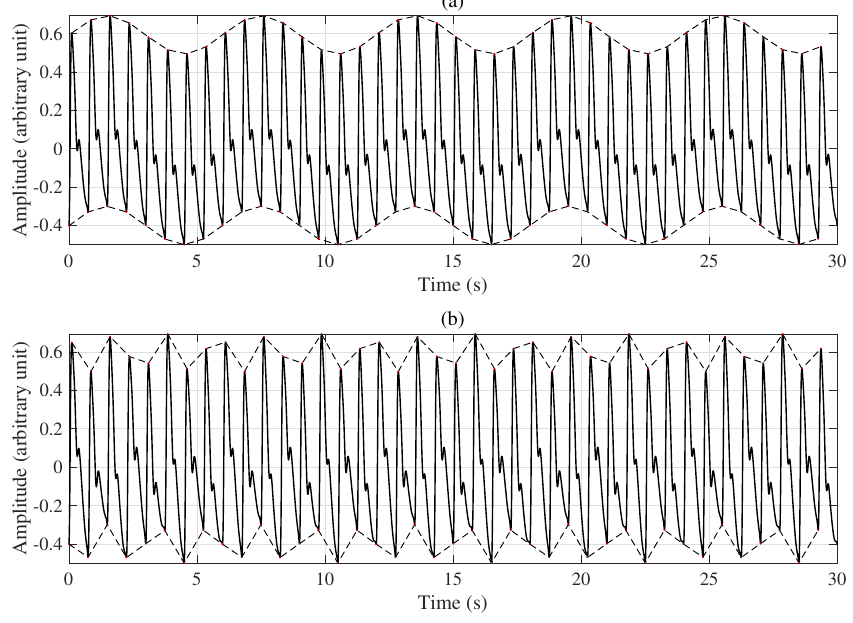
Figure 2. Upper panel ( a ) is an example (10 breath per minute) 4th record PPG signal, and lower panel ( b ) is an example (50 breath per minute) 24th record PPG signal, where the 4th record represents the 4th of 192